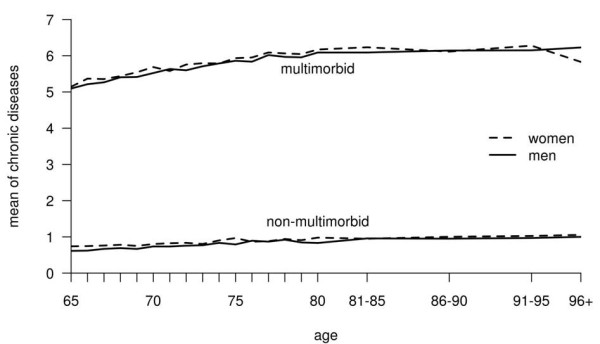
Mean number of chronic conditions according to age and gender in the non-multimorbid and the multimorbid sample. Means were calculated for each year of life until 80. Due to the small number of cases in old age, we generated four age groups for age > 80 years before calculation.